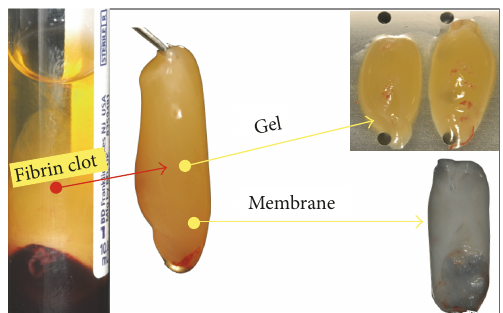
Figure 1: Preparation of L-PRF.